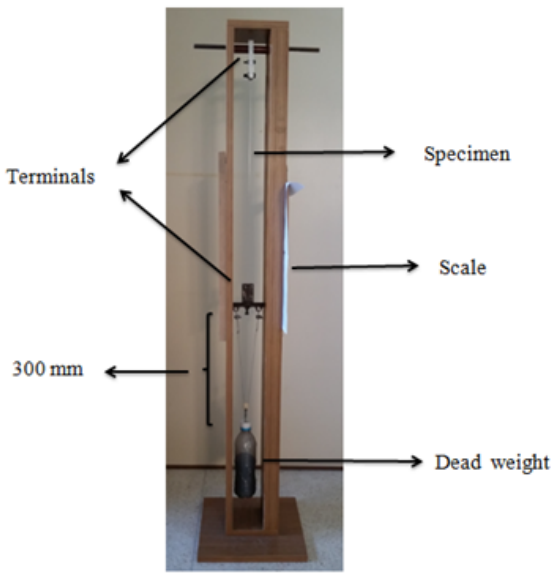
Figure 2. Impact testing device.